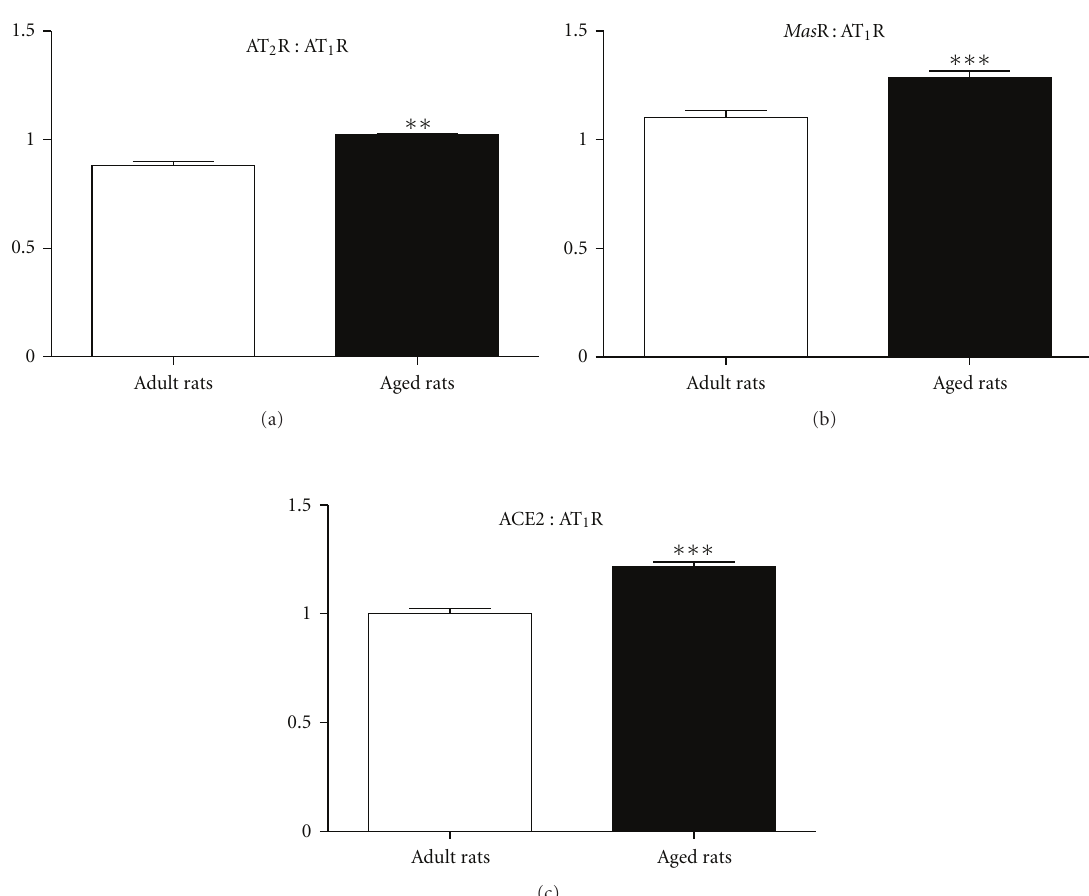
Figure 5: Ratios of (a) AT 2 R:AT 1 R, (b) Mas R:AT 1 R, and (c) ACE2:AT 1 R in adult and aged WKY rats. ∗∗ P < 0 . 01; ∗∗∗ P < 0 . 001 versus adult WKY